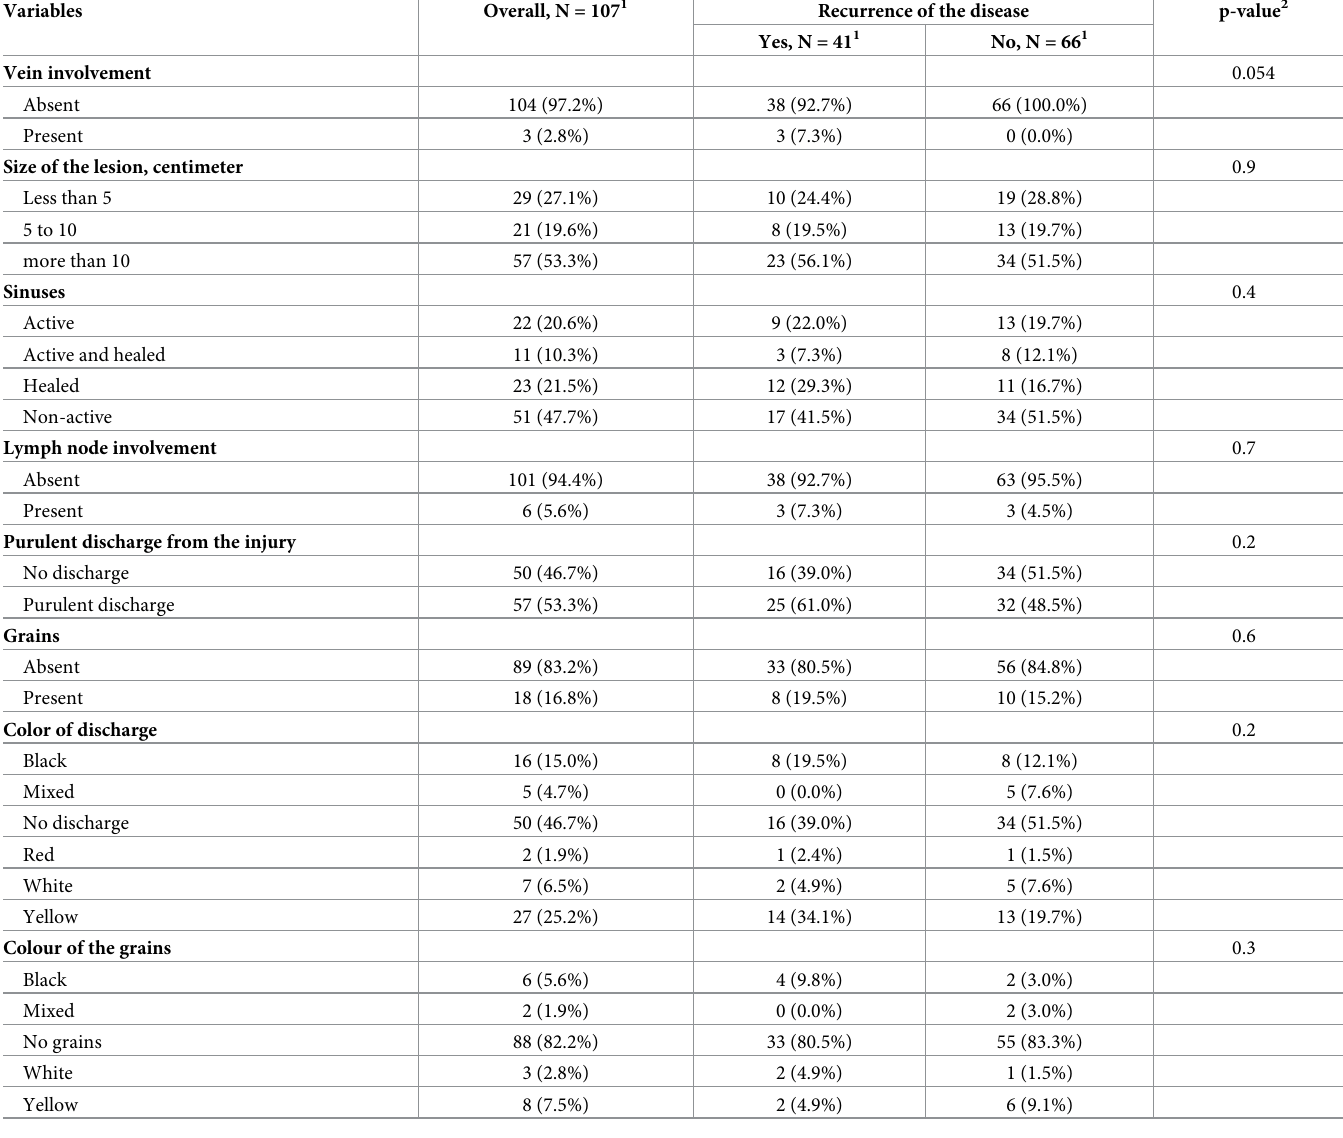
Table 3. Characteristics of mycetoma and lymphatic involvement in participants. (n =